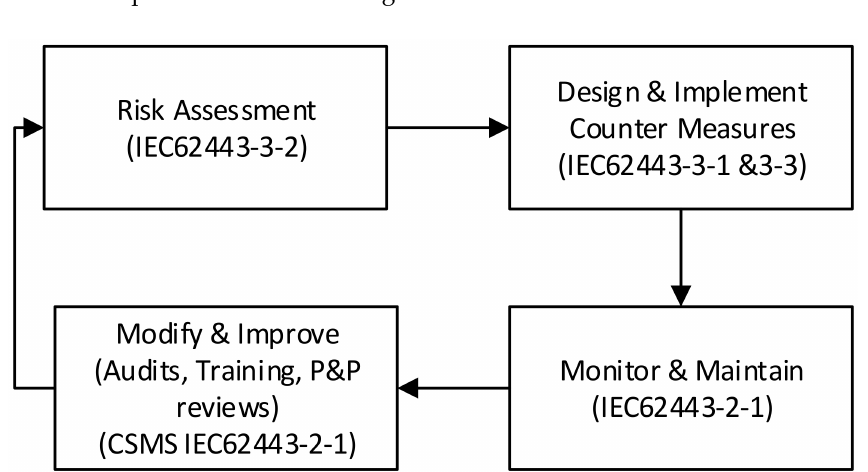
Figure 3. CPS security